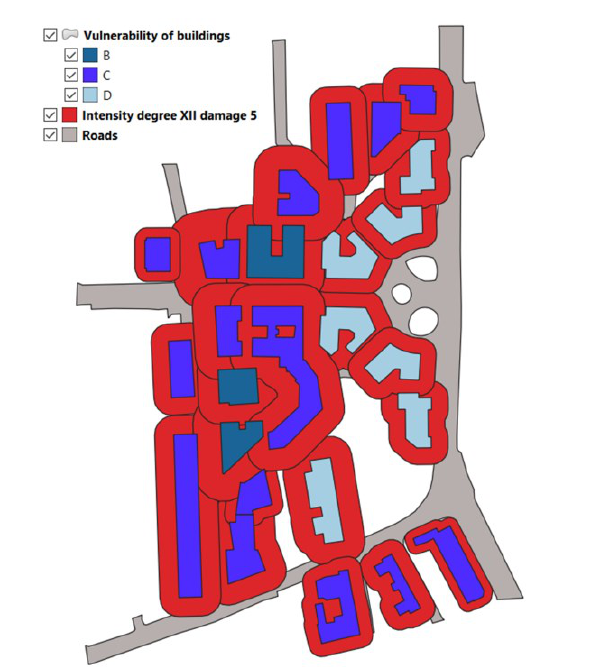
Figure 11. The scenario for intensity degree XII.